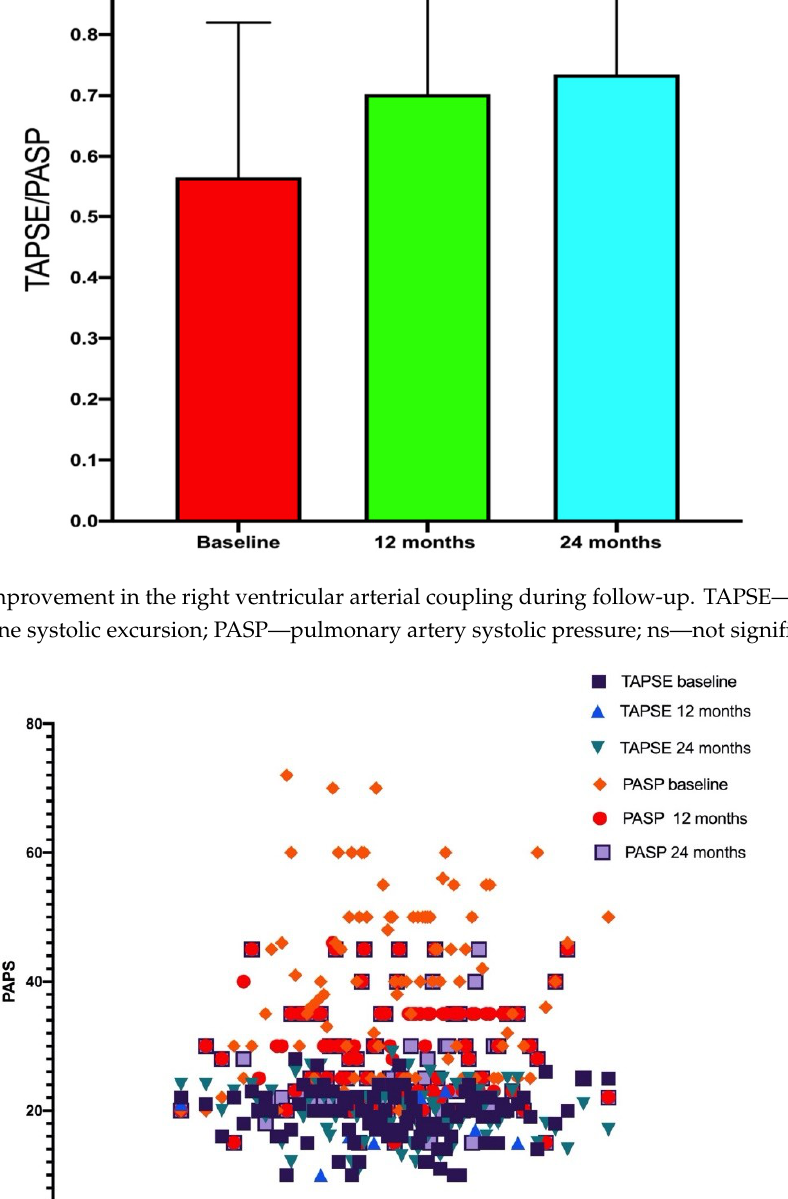
Figure 3. Scatterplot analysis of the PAPS and TAPSE at baseline and after sacubitril/valsartan therapy. TAPSE—tricuspid annular plane systolic excursion; PASP—pulmonary artery systolic pressure.